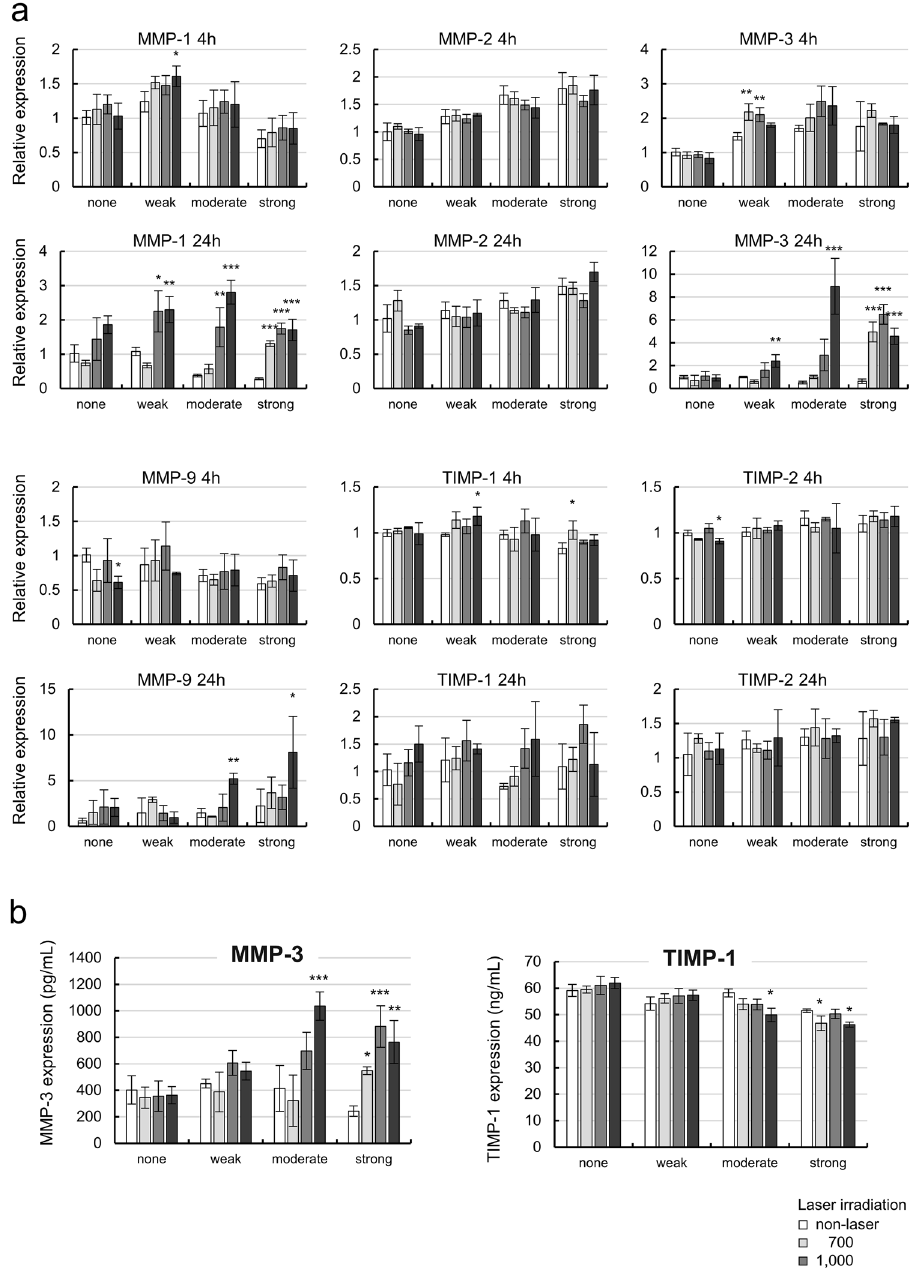
Figure 4. Expression levels of MMPs/TIMPs after 4 and 24 h of MP-laser irradiation of cells with each pigmentation intensity. ( a ) mRNA levels of MMPs/TIMPs after 4 and 24 h of MP-laser irradiation was measured by qPCR (n = 3). ( b ) MMP-3 and TIMP-1 protein expression in medium were measured by ELISA (n = 3). Data are represented as mean ± standard deviation of the mean. * P < 0.05, ** P < 0.01, *** P < 0.001 by Dunnet’s multiple comparisons